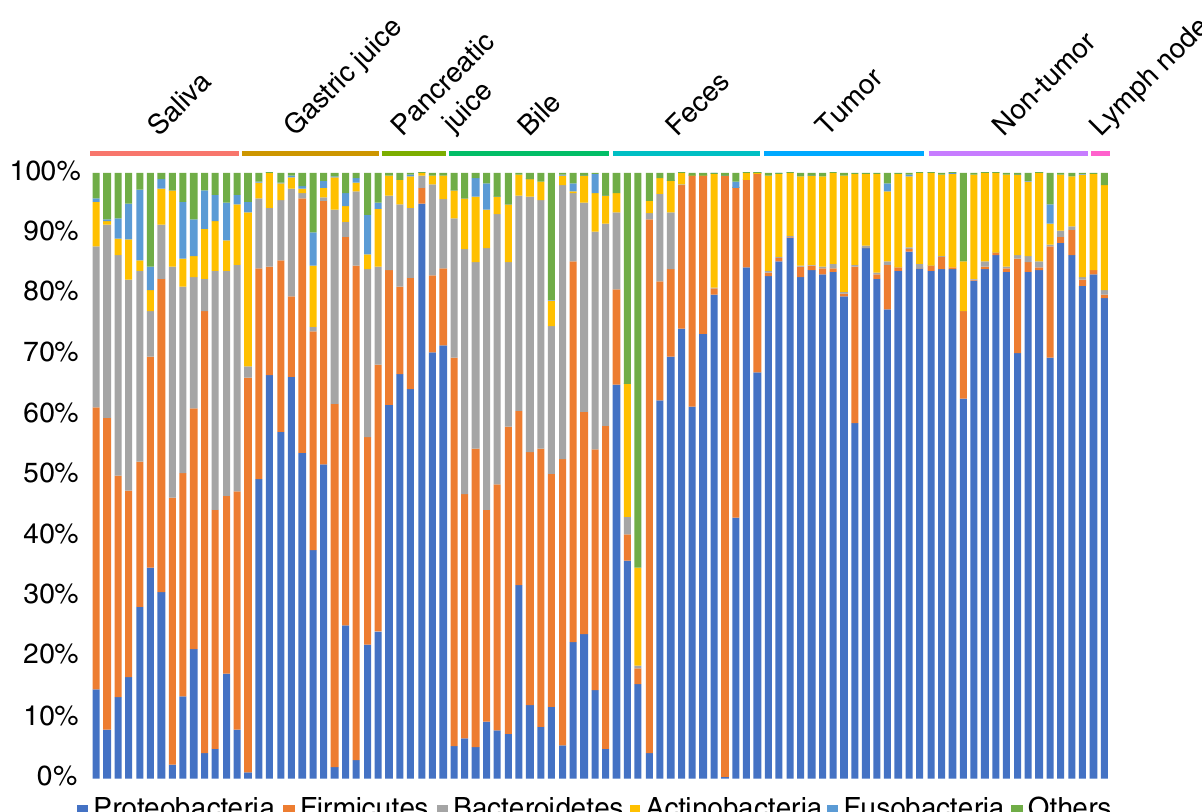
Figure 2. Profiles of symbiotic microbiome in the body fluids and tissues at phylum level. Site-specific distribution of relative abundance of each phylum are